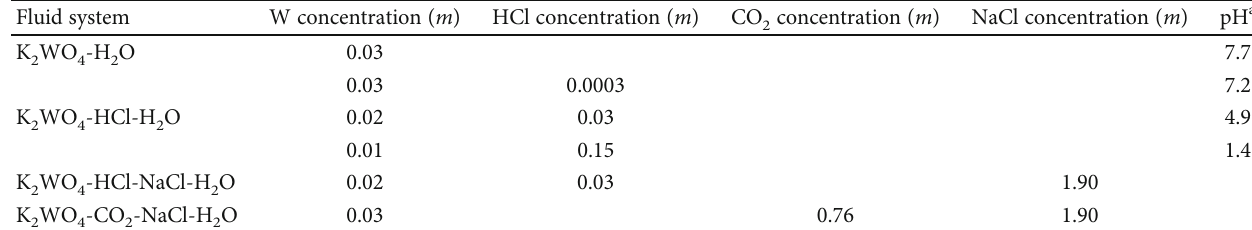
Table 1: Compositions of the sample solutions prepared at 22 °